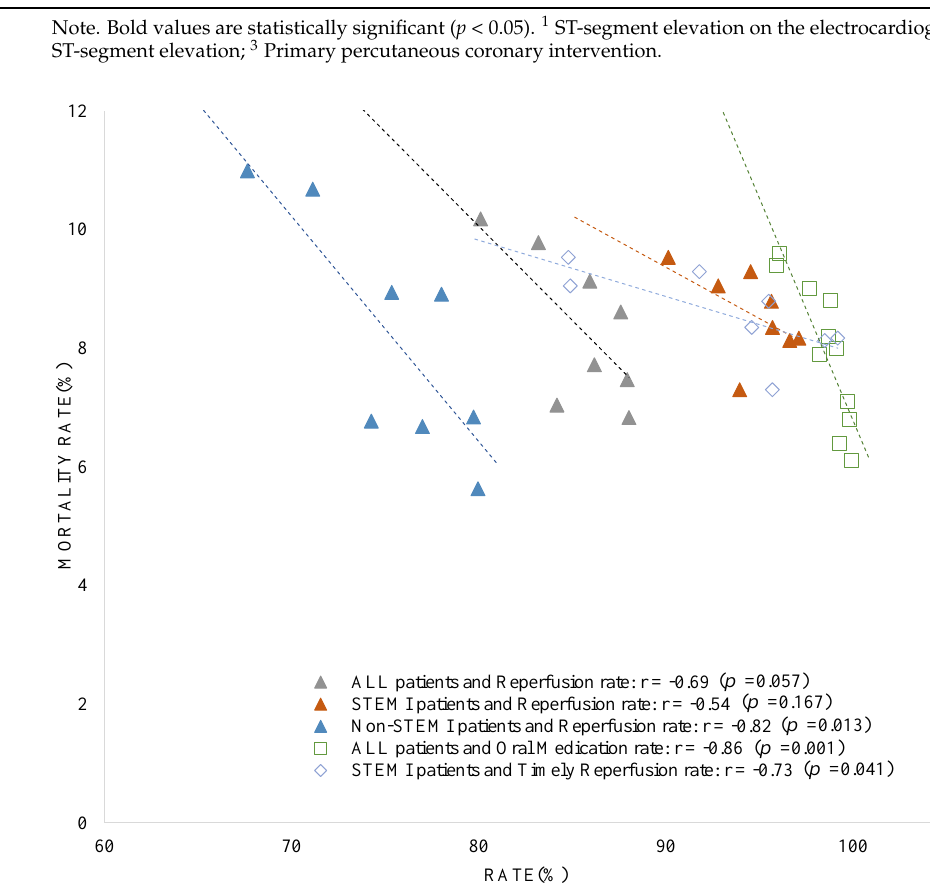
Figure 1. Relationship between annual 30 − days mortality and indicators of hospital type. (1) Trian- gles: Relationship between annual 30 − days mortality rate and annual reperfusion rate by hospital type (tertiary and general hospitals) for all patients including STEMI and NSTEMI (2009~2012); (2) Square: Relationship between annual 30 − days mortality rate and annual oral medication rate by hospital type (tertiary and general hospitals) for all patients; (3) Rhombus: Relationship between annual 30 − days mortality rate in STEMI patients and annual timely reperfusion rate by hospital type (tertiary and general hospitals) (2009~2012).